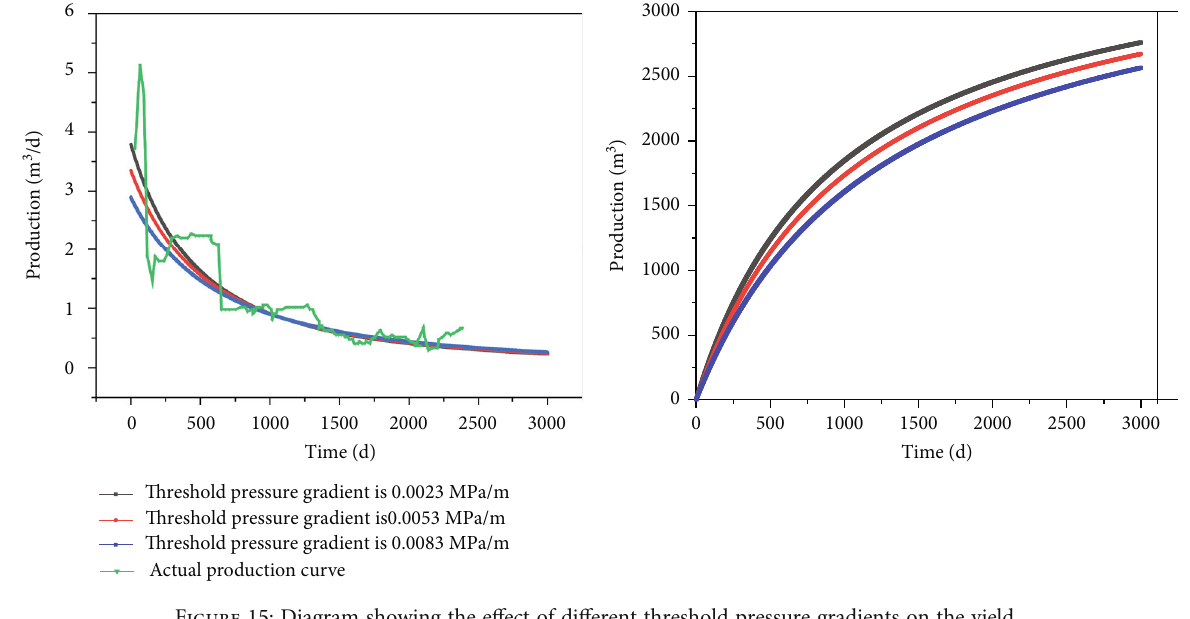
Figure 15: Diagram showing the e ff ect of di ff erent threshold pressure gradients on the yield.